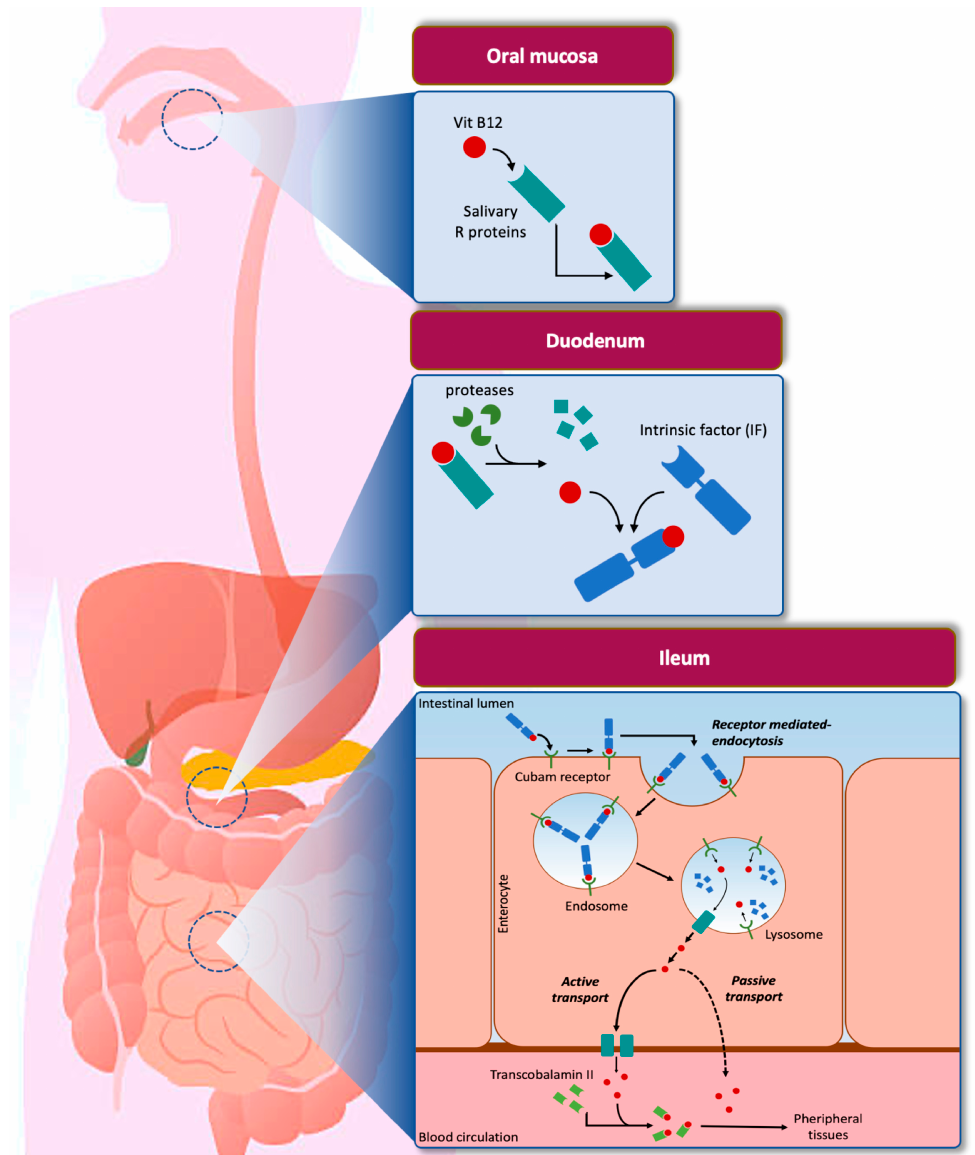
Figure 1. VitB12 uptake pathway. The scheme summarizes the main stages of VitB12 absorption and describes the factors and organs involved. See text for the complete description.